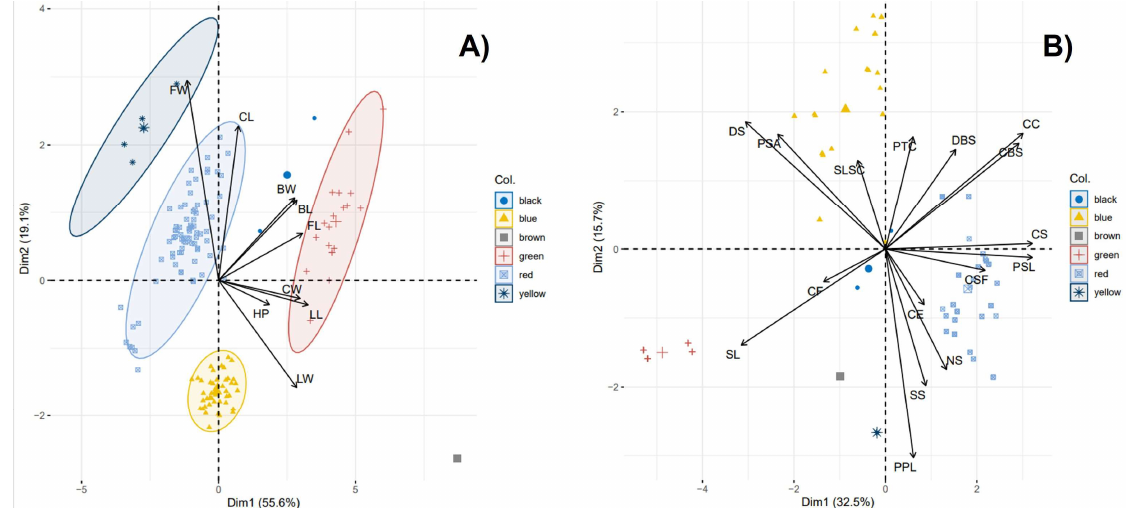
Figure 5. Principal component analysis using nine quantitative ( A ) and 16 qualitative ( B ) descriptors showing the separation of five groups of cotton species [Blue ( G. barbadense L.), red ( G. barbadense L. var. brasiliensis ), green ( G. hirsutum L.), black (unknown group G1), brown (unknown group G2) and yellow (unknown group G3)] collected in the province of La Convención, in the districts of Echatari and Megantoni, Cusco-Peru. Flower length (FL), flower width (FW), bracts length (BL), bracts width (BW), capsule length (CL), capsule width (CW), height of plant (HP), leaf length (LL), leaf width (LW), color speck (CE), presence of spots on flowers (PSF), color stained flower (CSF), color of flower (CF), position of stigma anthers (PSA), disposal seeds (DS), number of seeds (NS), characteristics of seeds (CS), seed shape (SS), dentate bracterae seeds (DBS), color of bracterae seeds (CBS), shape of longitudinal section capsules (SLSC), characteristics of capsules (CC), prominence of tip capsules (PTC), leaf shape (SL), and presence of pubescence leaf (PPL).